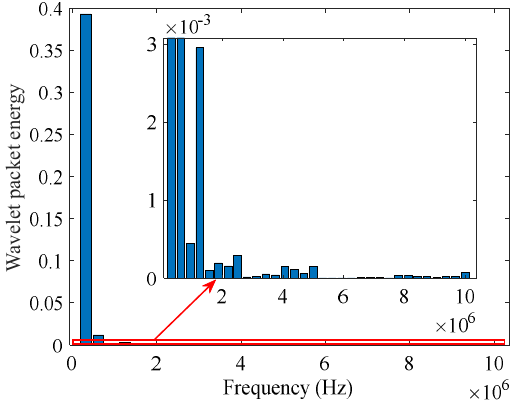
Figure 8. Wavelet packet energy of the undamaged pipe.